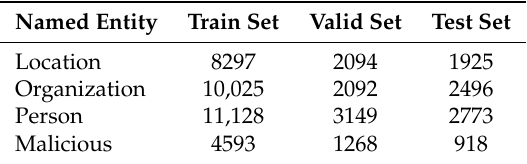
Table 1. Statistics of named entities in CoNLL 2003 found in the training, development, and test sets. The highest proportion in CoNLL 2003 is location, followed by person, organization, and miscellaneous in that order.